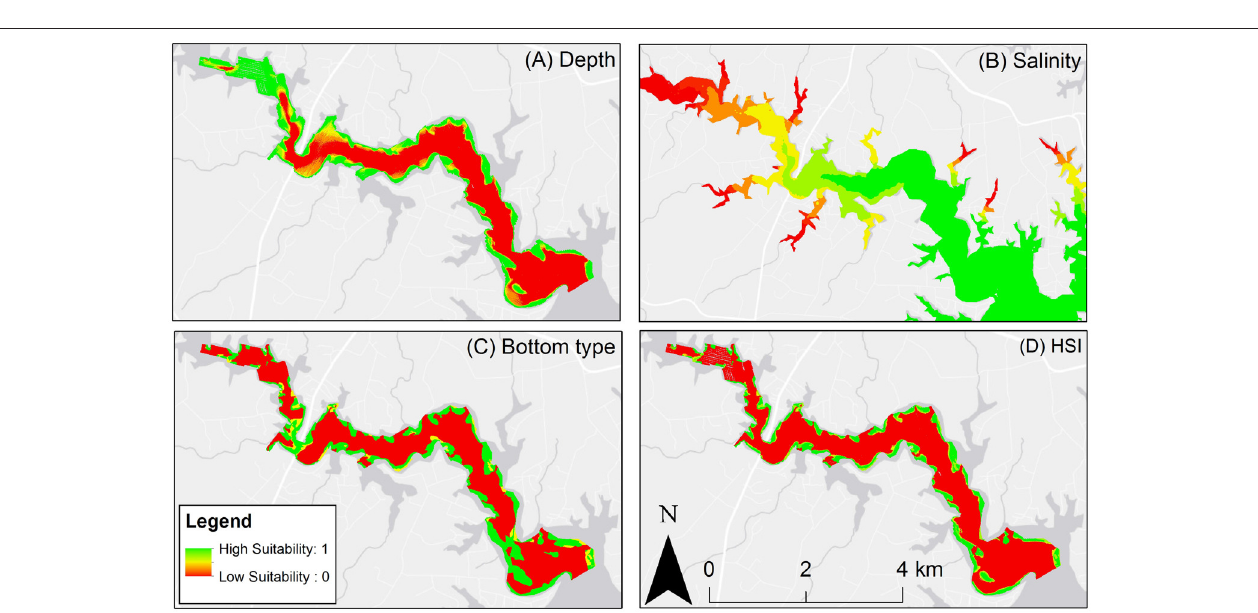
FIGURE 4 | (A) Depth suitability layer. (B) Salinity suitability layer. (C) Bottom type suitability layer. (D) Habitat suitability index output, red areas are unsuitable oyster habitat, green areas are optimal oyster habitat.